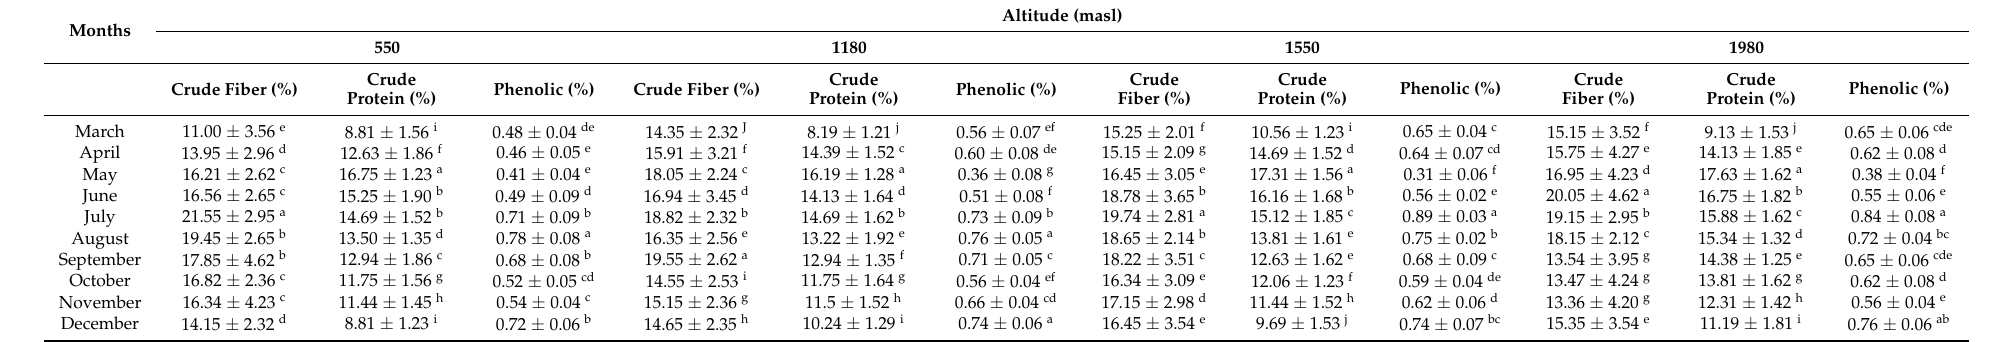
Table A4. Provenance and monthly variation in crude fiber, crude protein, and phenolic content (%) in C. australis foliage ( ± SD). Means followed by the same letter are not significantly ( p < 0.05)